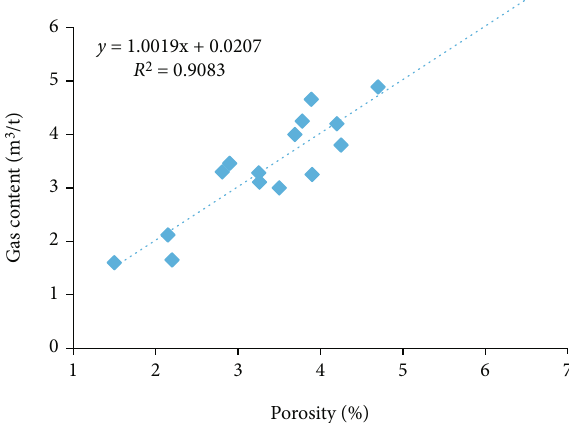
Figure 6: Relationship between porosity and adsorbed gas